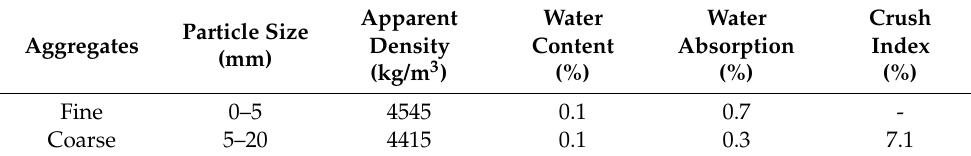
Table 2. Basic performance of magnetite aggregate.